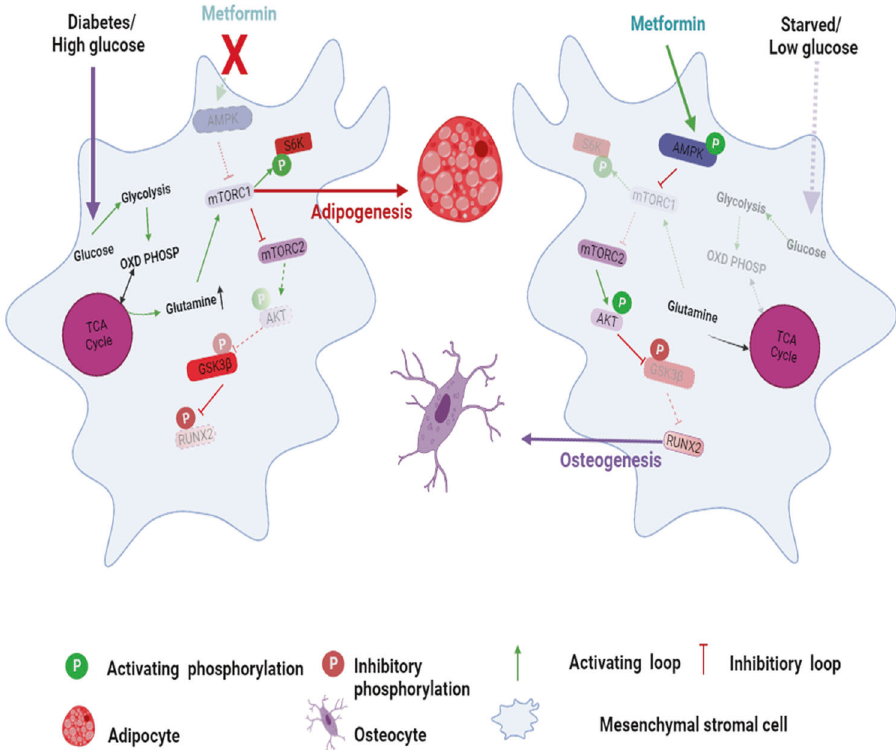
Fig. 7 Schematic representation of mTOR crosstalk in RUNX2 regulation. This fi gure summarizes, along with the fi ndings from the current study, where, at physiological levels, activation of mTORC2 by PIP2 resulted in activation of AKT by phosphorylation at Ser473. pSer473AKT inhibits GSK3 β by phosphorylation at Ser9. Inhibitory/inactive Ser-9GSK3 β fails to interact with RUNX2, and thus RUNX2 is stabilized from its degradation. Active RUNX2 can enhance ECM calci fi cation and promote osteogenesis of MSCs. Increasing levels of glucose and glutamine or insulin can hyperactivate mTORC1 which through active p-70S6k inhibits mTORC2. Inhibition of mTORC2 results in destabilization of RUNX2 through the loss of pSer473AKT, which leads to activation of GSK3 β . Active GSK3 β interacts with RUNX2 and primes it for ubiquitination. mTORC1 also activates lipogenesis and helps to increase adipogenesis. Metformin activates AMPK by phosphorylation at Thr172, which inhibits mTORC1 and rescues mTORC2 under high-glucose and/or high-glutamine studies using cell lines except freshly isolated BM-MSCs and immunopre- cipitation experiments due to limitations in the use of animals, whereas each mouse was considered one subject for the in vivo experiments.